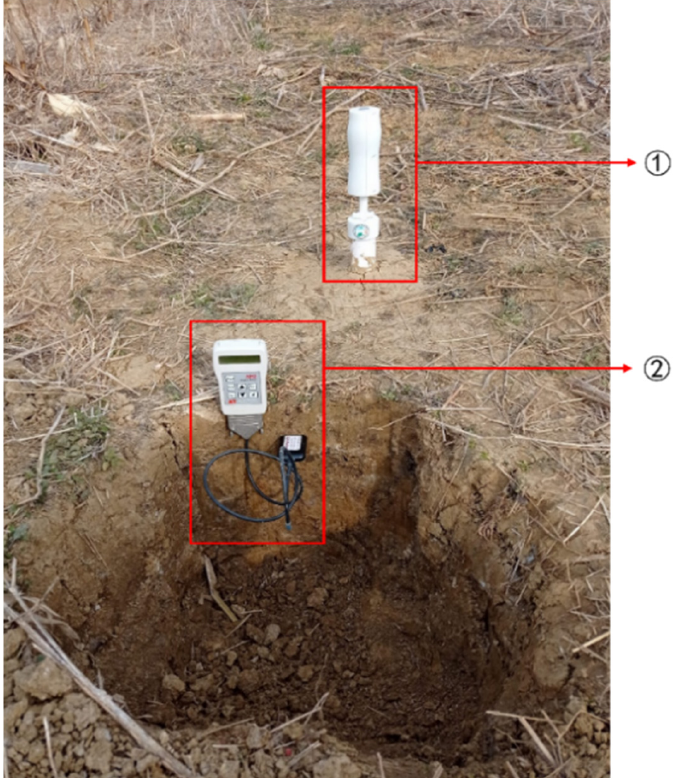
Figure 17. Field performance test chart of self-developed moisture sensor. ① Pull-out soil profile moisture sensor; ② WET-2 commercial moisture sensor.